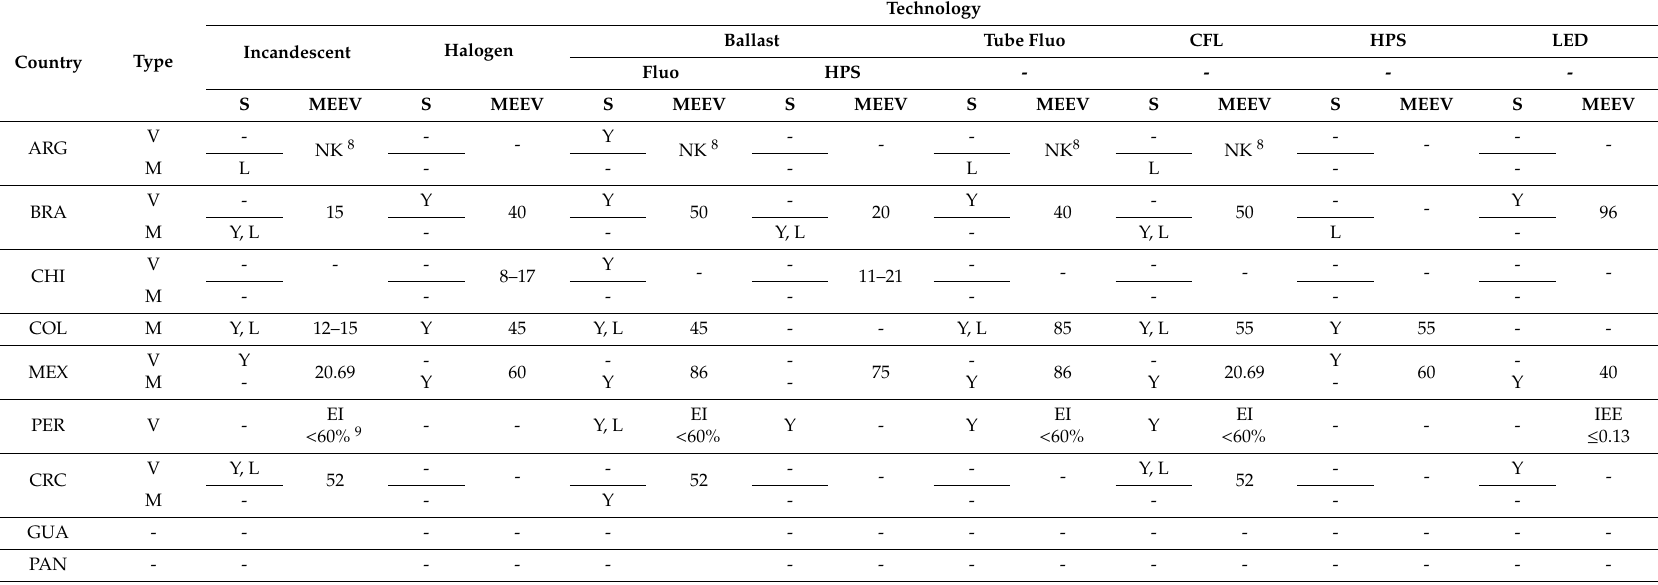
Table 4. Comparison of lighting standards in the region. We show the status (S) of whether a minimum energy performance standard exists (Y) and / or whether this is accompanied by labelling (L). Fluo stands for fluorescent lamps, CFL stands for compact fluorescent lamps, and HPS stands for high-pressure sodium. Source [60]. We also show the minimum energy e ffi ciency values for the reviewed countries are in lumen per watts (lm / W) unless otherwise